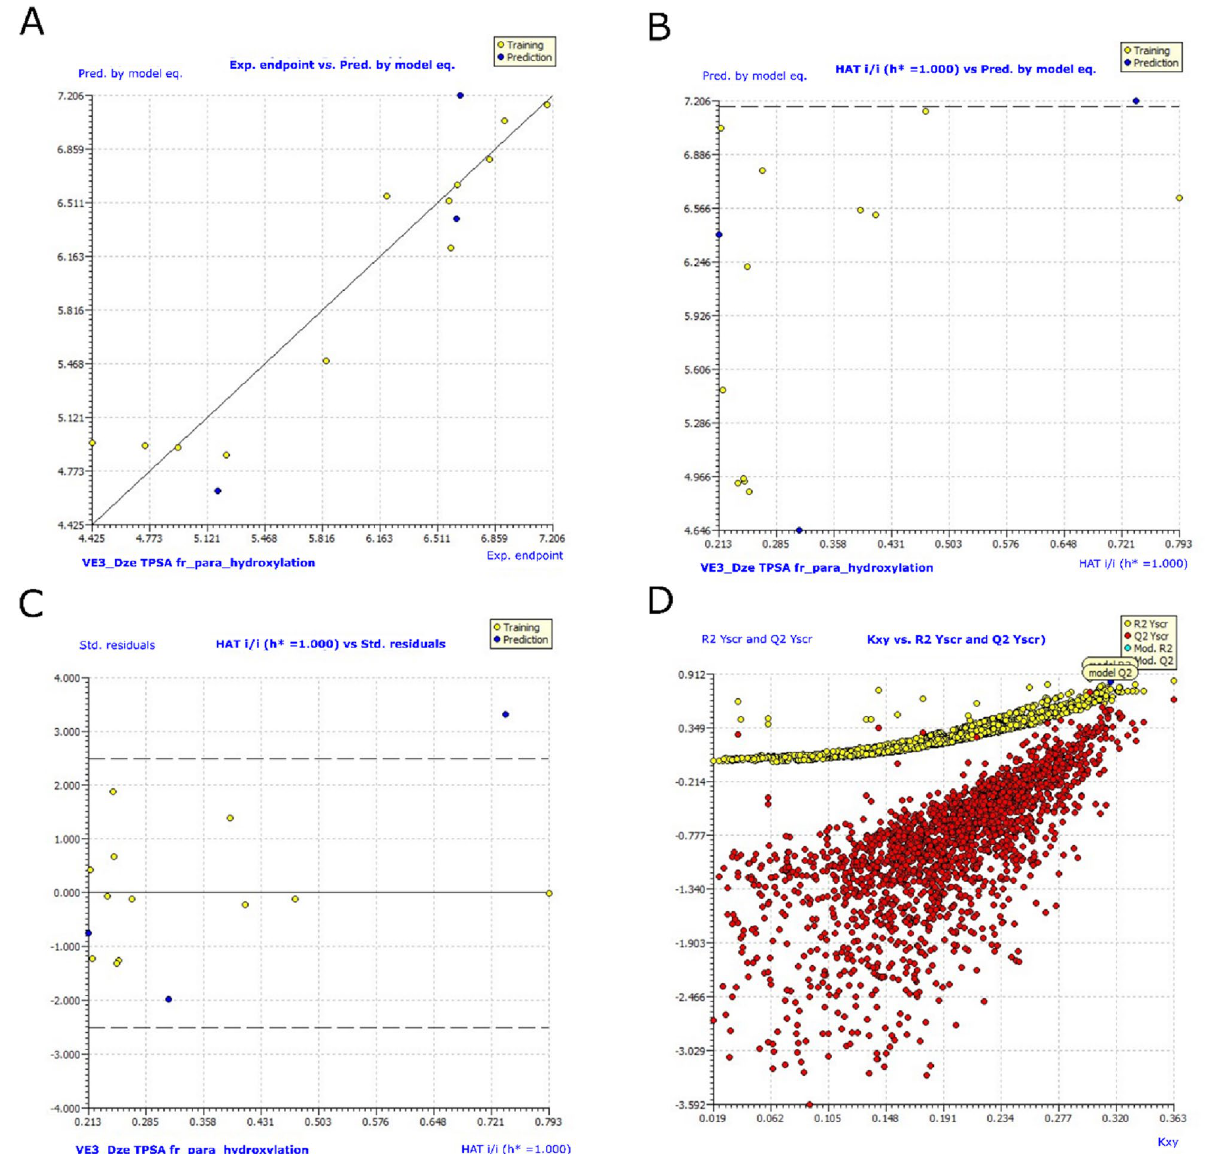
Figure 10. Graphs for model 9 . ( A ) Graph of experimental vs predicted pIC 50 values; ( B ) Insubria plot; ( C ) William’s plot; ( D ) Y-scrambling